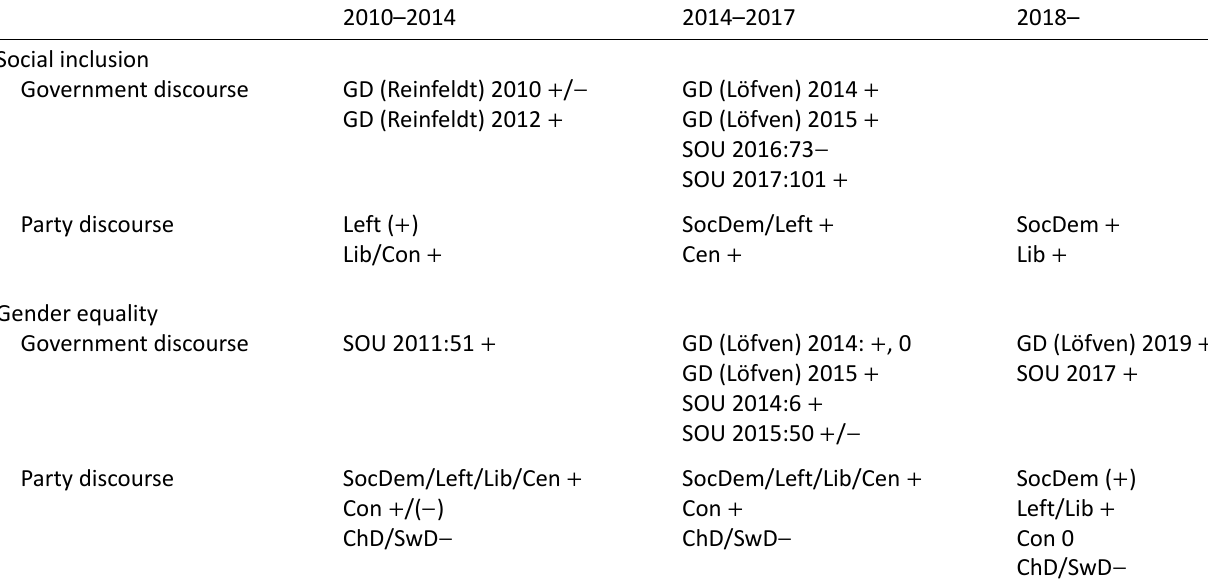
Table 2. Overview of government and party discourses regarding parental leave in Sweden during the